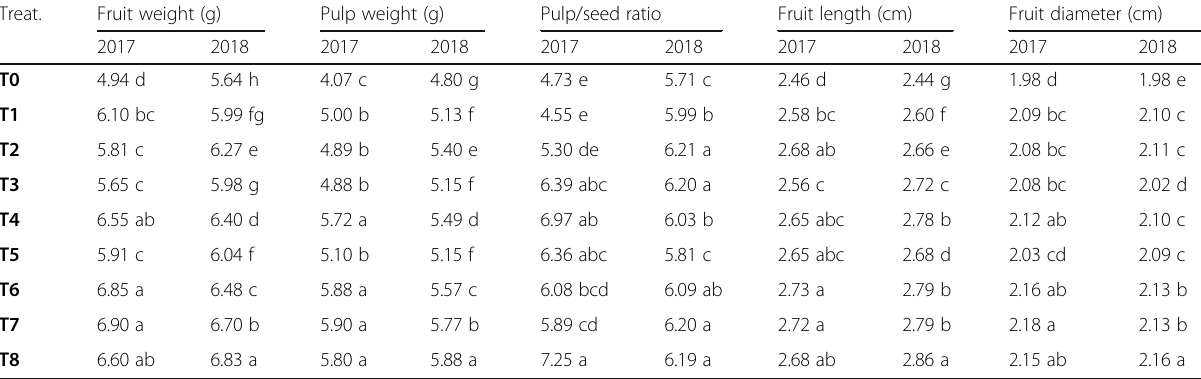
Table 6 Effect of foliar application of B 2 O 3 and ZnO nanoparticles on fruit traits of Picual cultivar in 2017 and 2018 seasons Treat. Fruit weight (g) Pulp weight (g) Pulp/seed ratio Fruit length (cm) Fruit diameter